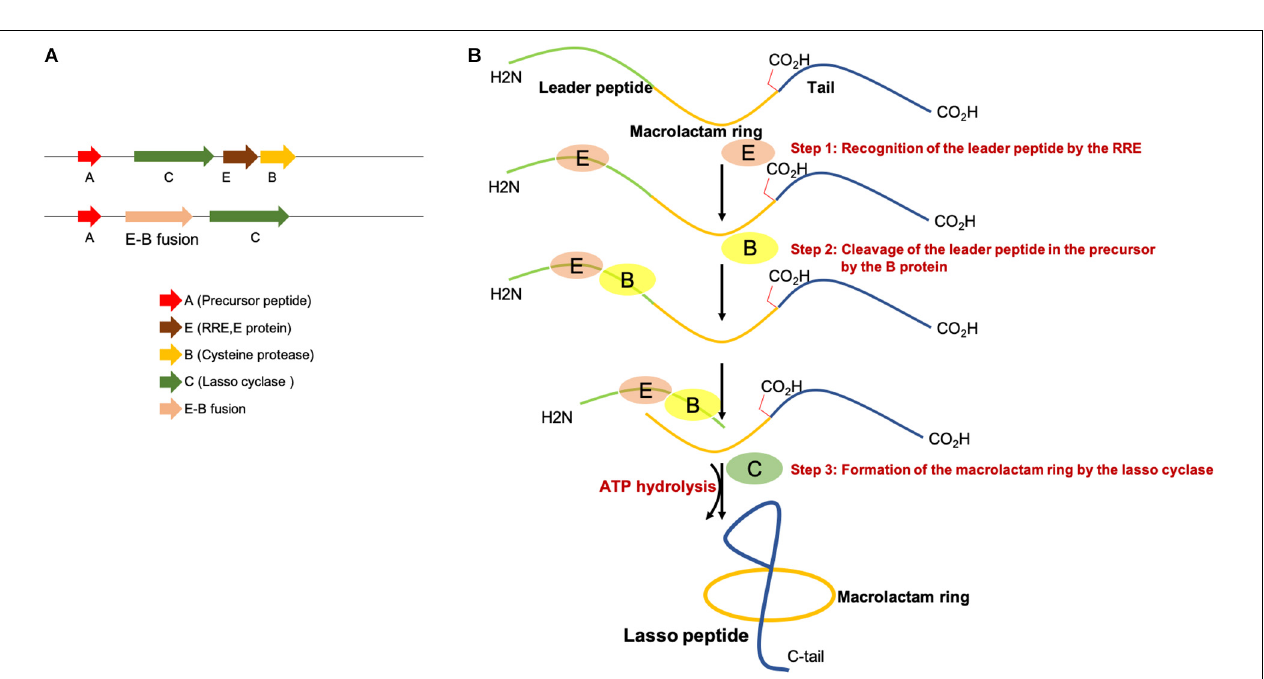
FIGURE 2 | (A) Representative lasso peptide biosynthetic gene clusters with a separate E and B protein or E-B fusion. (B) Proposed mechanism of lasso peptide biosynthesis, involving three steps.